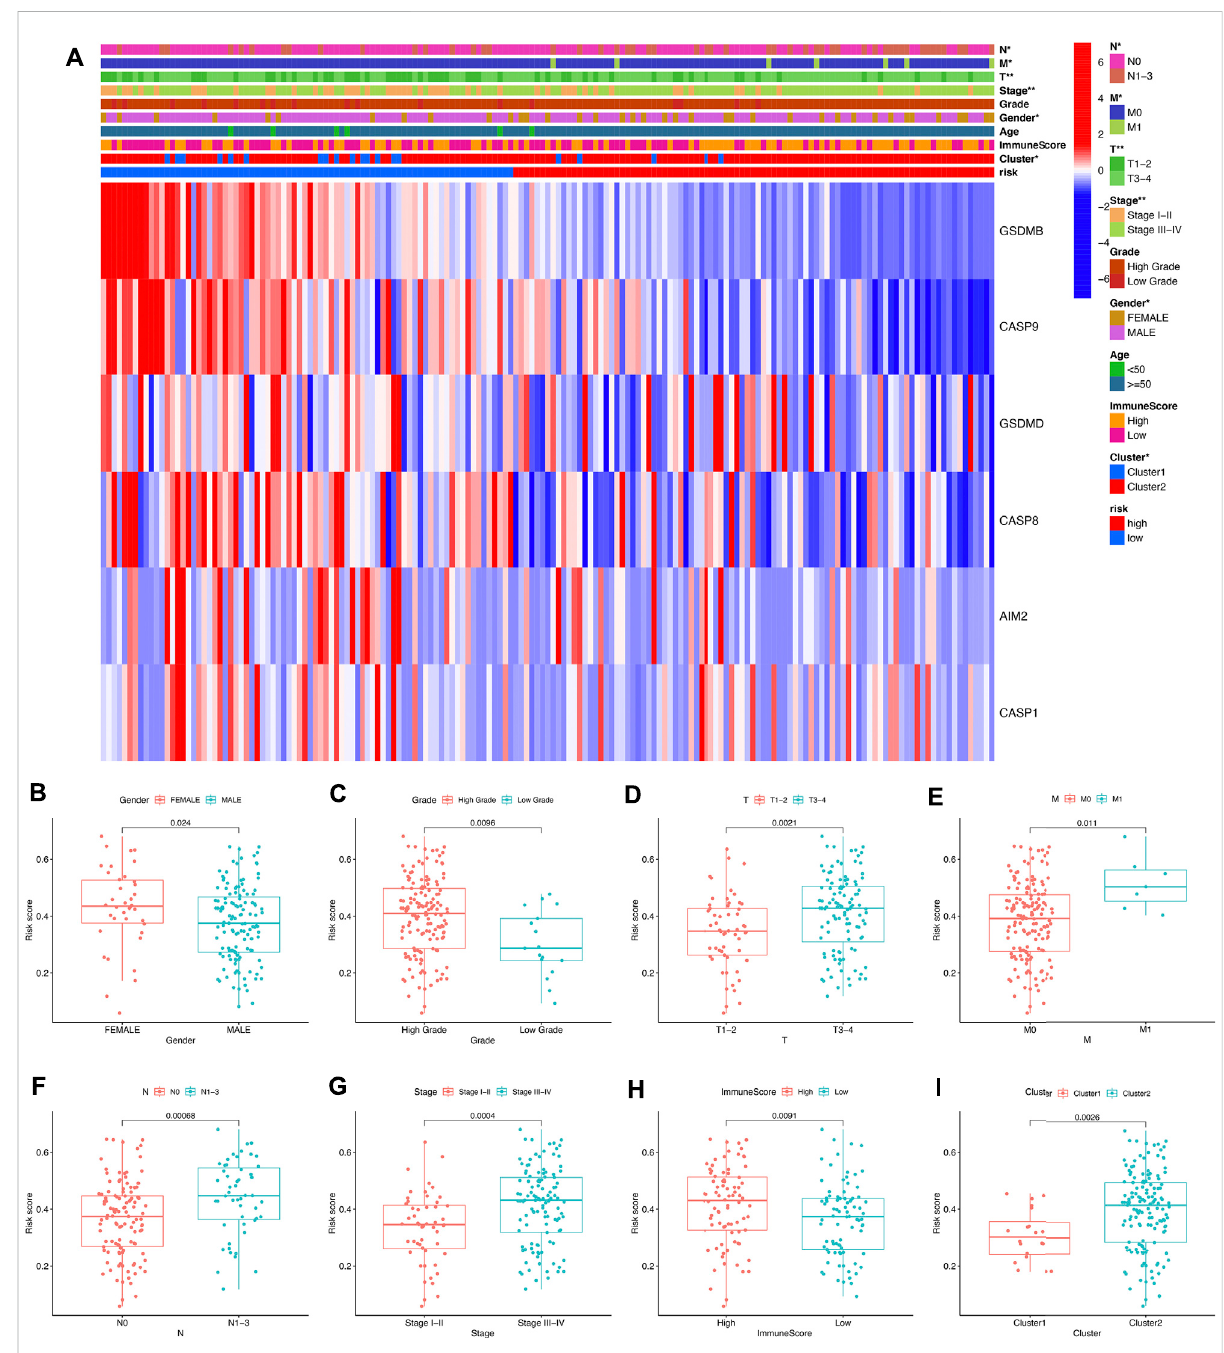
FIGURE 8 Risk score correlated with clinicopathological features in bladder cancer. (A) The heatmap revealed the difference of clinical characters between thehigh- and low-riskgroups in bladder cancer. The risk score in differentgender (B) , tumor grade (C) , pT stage (D) , pM stage (E) , pN stage (F) , clinical stage (G) , immunoScore (H), and cluster (I) of bladder cancer patients. * p < 0.05, ** p <